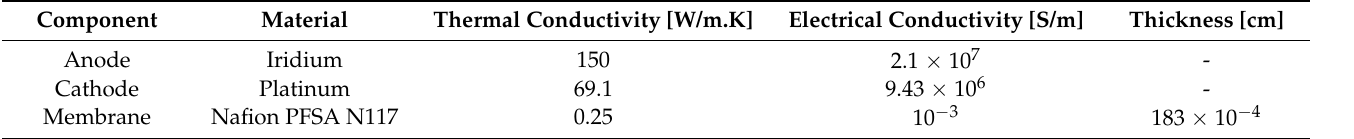
Figure 4. Views of the PEM electrolyzer cell to point out its geometry: ( a ) top view; ( b ) side view. Table 3. Synthesis of materials, geometry, and electrical and thermal properties of the PEM elec- trolyzer